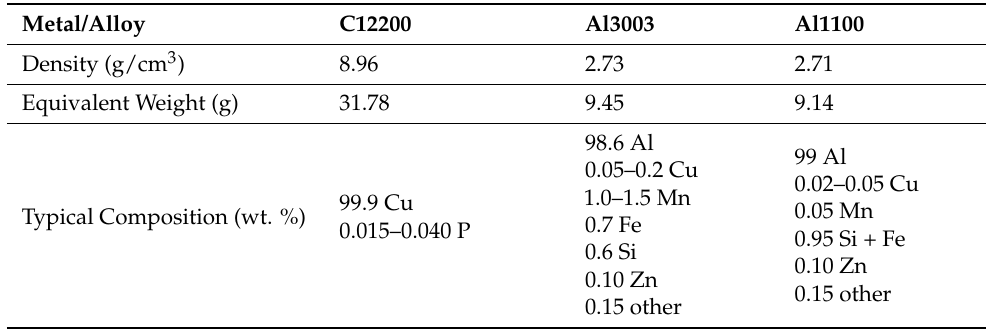
Table 1. Densities, equivalent weights, and composition of Cu and Al alloys. Compositions listed are maximum wt. % unless range is